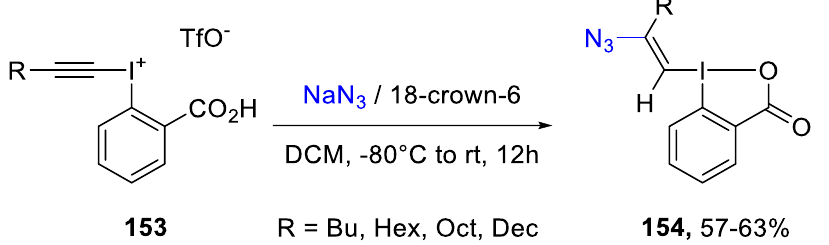
Scheme 32. First reported synthesis of vinylbenziodoxoles 154 .